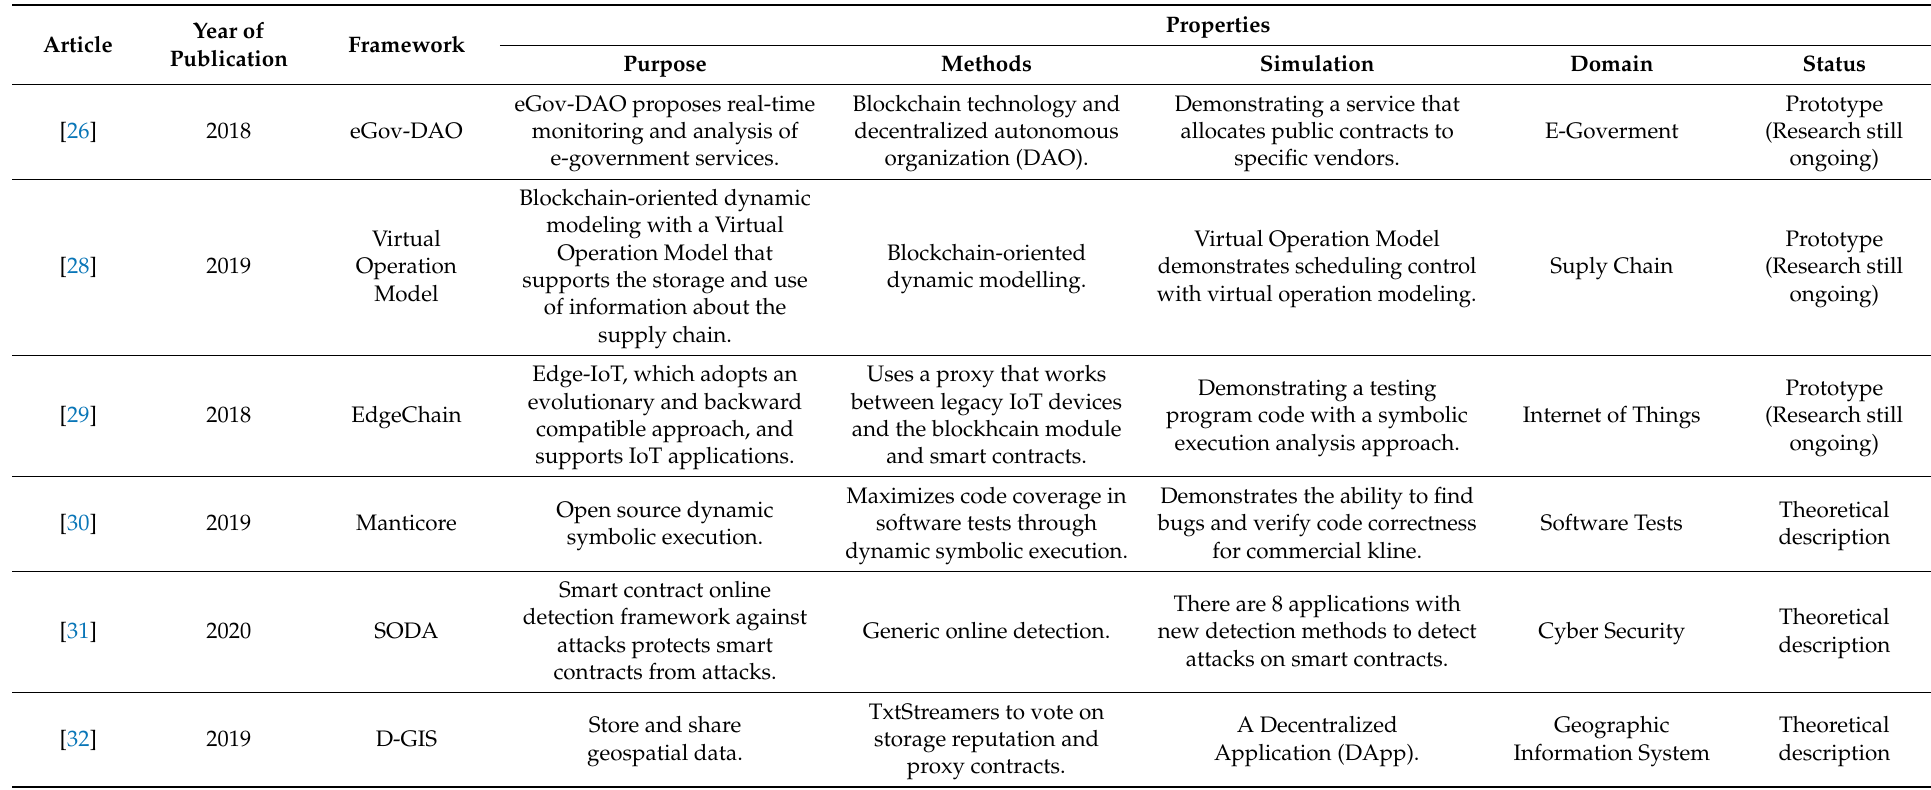
Table 1. Smart Contract Framework and Its